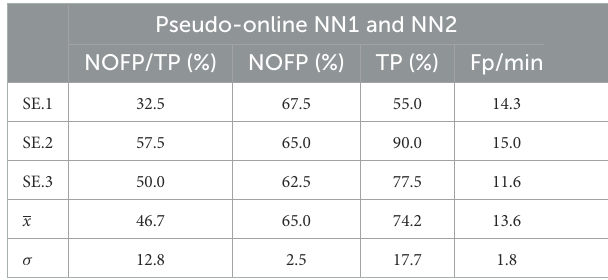
The results show per subject the average of the leave-one-out cross validation of the training